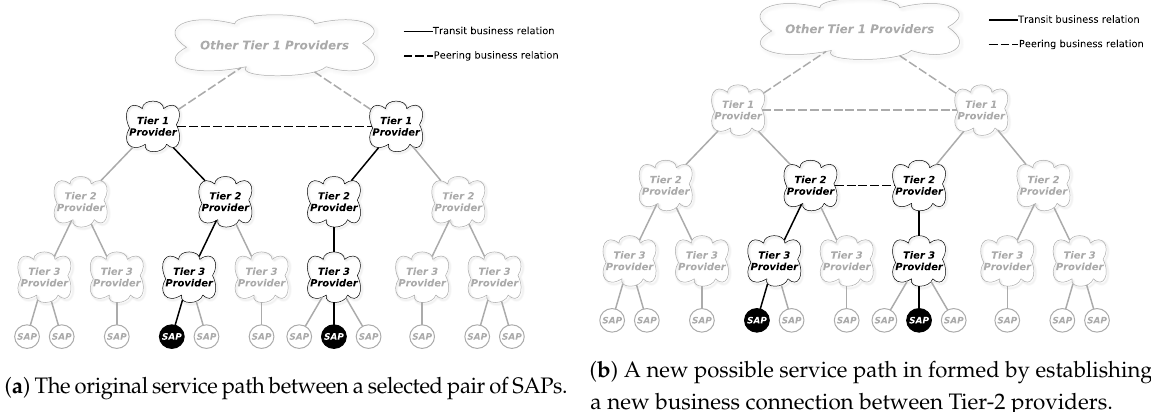
Figure 1. Examples of the graph model of 5G infrastructure